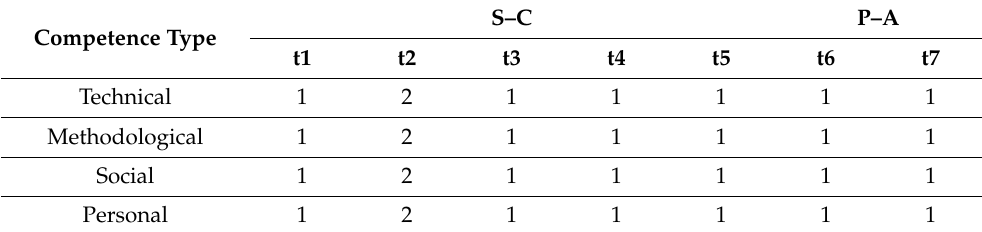
Table 12. Evidenced impact level of competence on adopting different ICT forms.